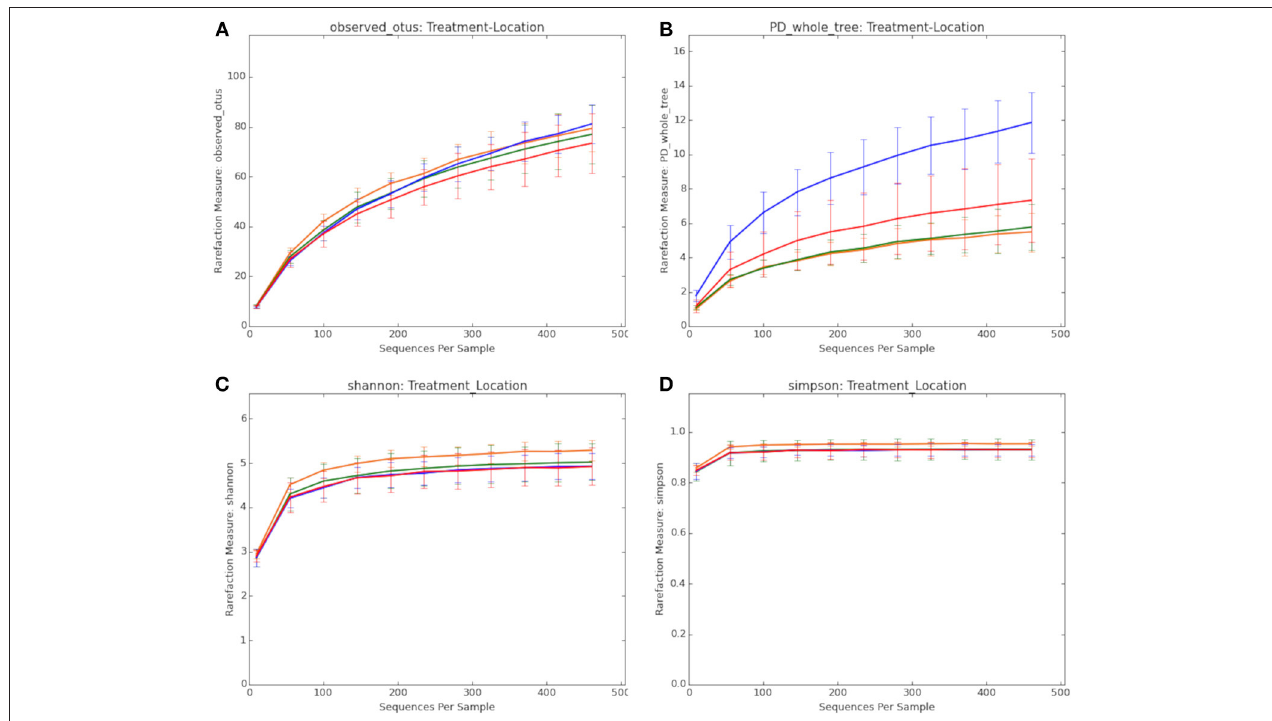
FIGURE 1 | Comparison of the composition of the microbiota in treatment groups. (A) Observed OTUs. (B) Faith’s phylogenetic diversity. (C) Shannon alpha diversity index. (D) Simpson alpha diversity index. Treatment groups include: BMD treated, cecum (red line); BMD treated, distal colon (blue line); Control, cecum (orange line); Control, distal colon (green